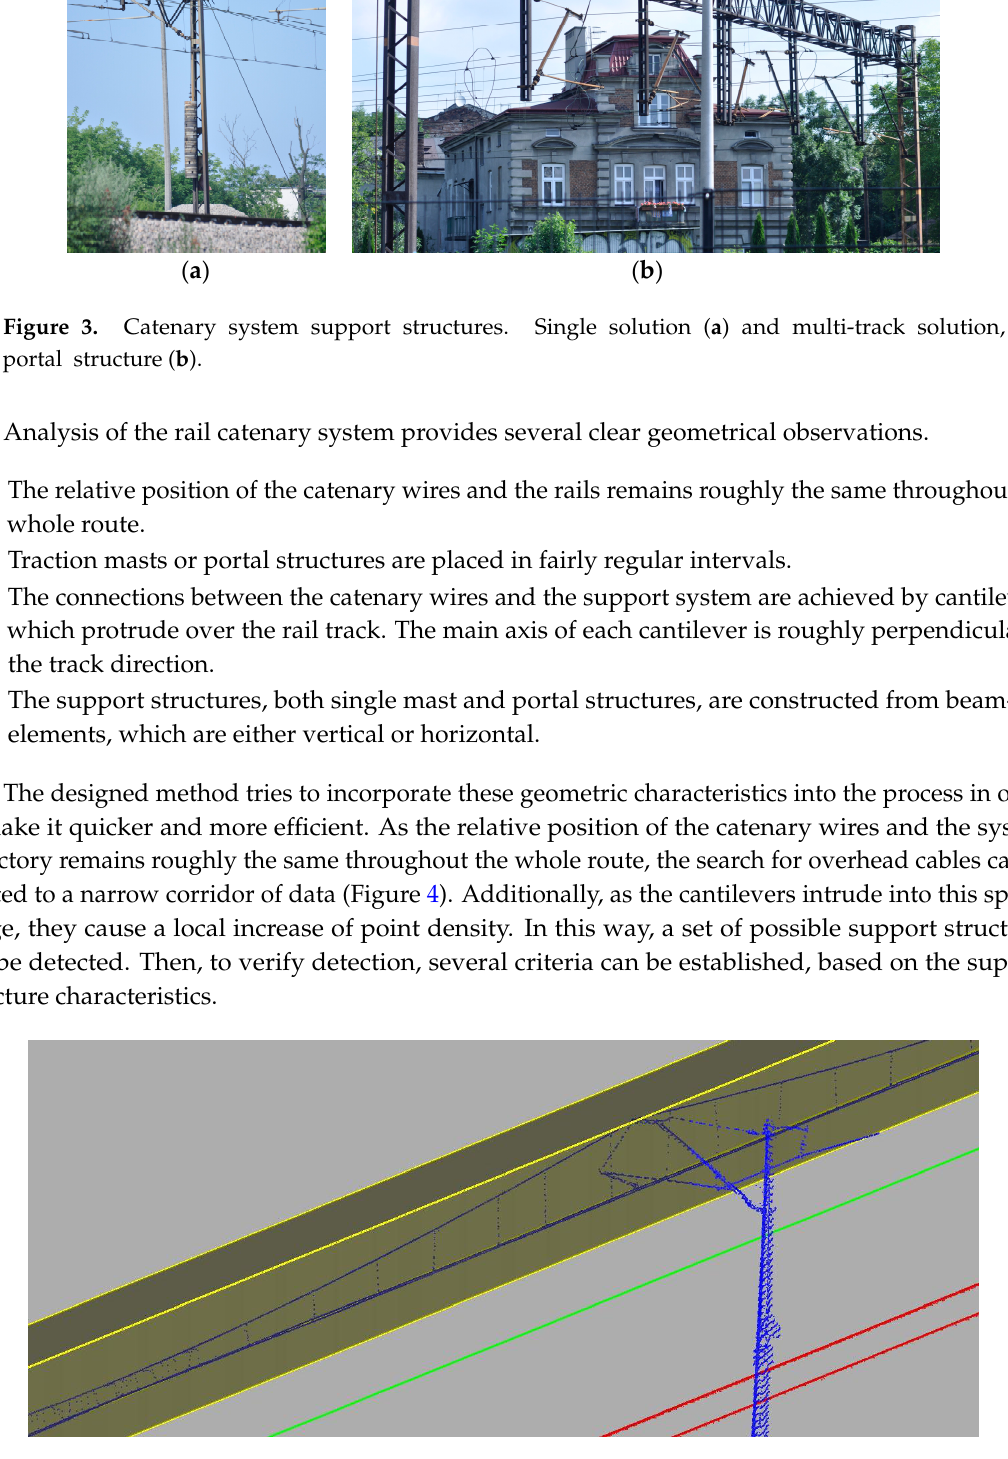
Figure 4. Narrow corridor containing catenary wires against selected points from the MMS point cloud. Catenary system, blue; rails, red; trajectory, green.